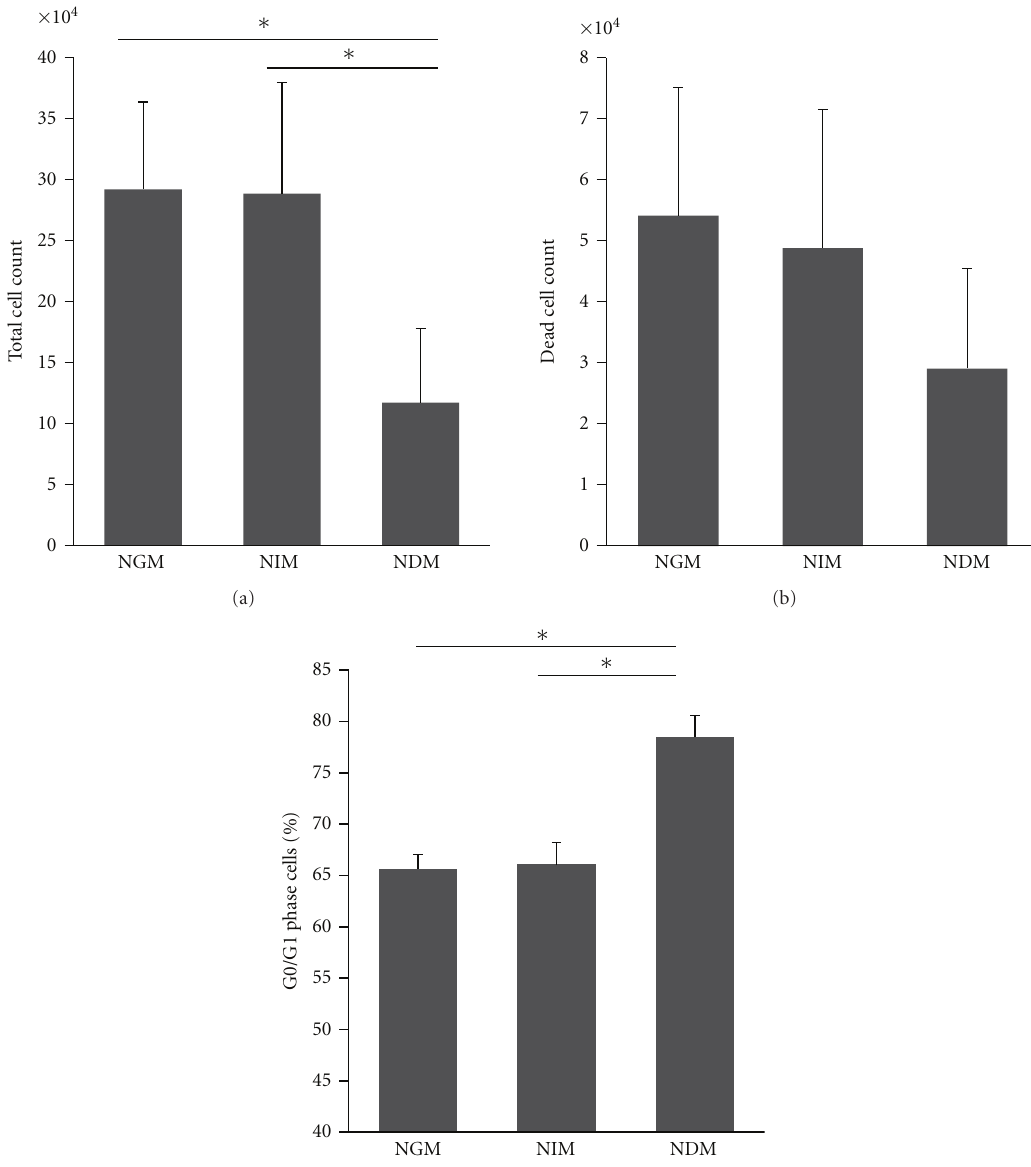
Figure 5: Cell count and cell cycle transition of hMSCs during neural di ff erentiation. (a) Cell counts were determined 36hr after changing to a NDM (corresponding to 76hr after culturing in NGM and to 60hr after changing to a NIM). Data represent means ± SD ( n = 4). ∗ P < . 01. (b) The numbers of death cells were determined by counting the trypan blue stained cells in a hemocytometer. (c) Flow cytometric cell cycle analysis of hMSCs cultured under 3 di ff erent culture conditions. DNA content-related cell cycle distribution of hMSCs was determined 24hr after changing to a NDM. Data represent means ± SD ( n = 6–9). ∗ P < . 01. NGM: normal growth media; NIM: neural induction media; NDM: neural di ff erentiation